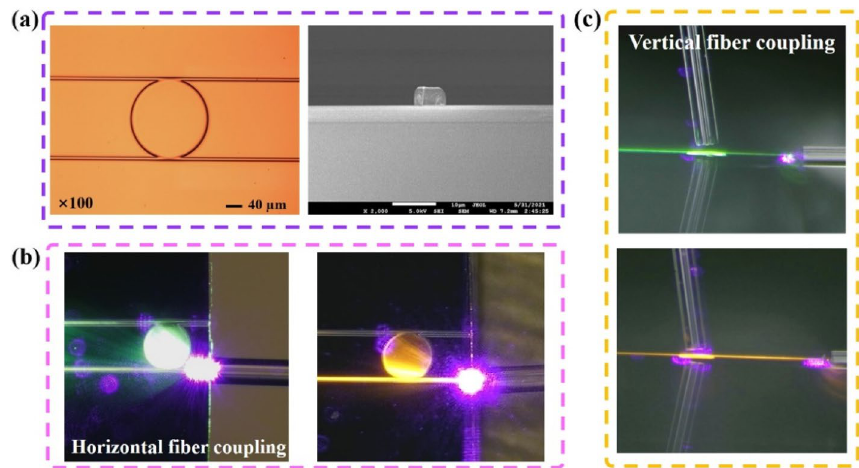
Fig. 5 Structural size of the waveguide structure and the horizontal and vertical fiber coupling of 3D integrated single-microdisk optical sources excited by 405 nm wavelength pumping light. a The top-view (optical microscope) and cross-sectional view (SEM image) of the gain waveguide structure; b and c were the images of horizontal fiber coupling for inputting pumping light and vertical fiber coupling for outputting fluorescence, respectively